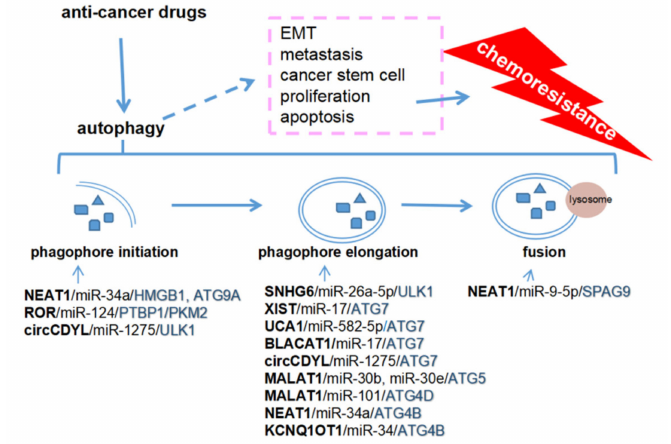
Figure 2. Competing endogenous RNAs (ceRNAs) regulate autophagy to promote chemoresistance. NEAT1 and ROR are involved in the initiation of phagophore formation, and SNHG6, XIST, UCA1, BLACAT1, KCNQ1OT1, MALAT1, and NEAT1 in the elongation of autophagosome. NEAT1 also regulates lysosome localization by upregulating SPAG9. ceRNAs-mediated autophagy may promote chemoresistance via EMT, metastasis, cancer stem cells, proliferation, and